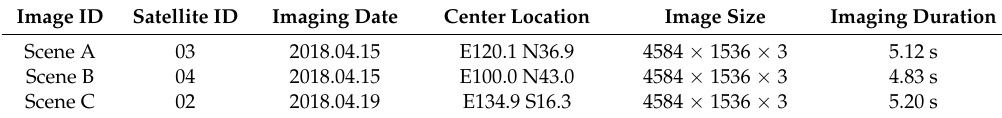
Table 2. Basic information of the datasets.